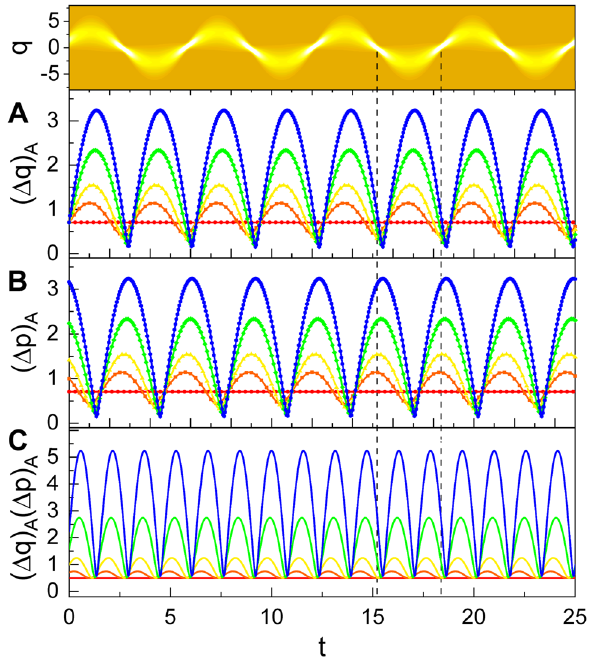
Figure 4. Time evolution of quadrature fluctuations (� q ) A ( A ), (� p ) A ( B ), and the uncertainty product (� q ) A (� p ) A ( C ) for several different values of c 1 . The value of c 1 that we have chosen is 1 for red, 2 for orange, 4 for yellow, 10 for green, and 20 for blue lines. We have used c 2 upper part, the evolution of the probability density is shown with the choice of c 1